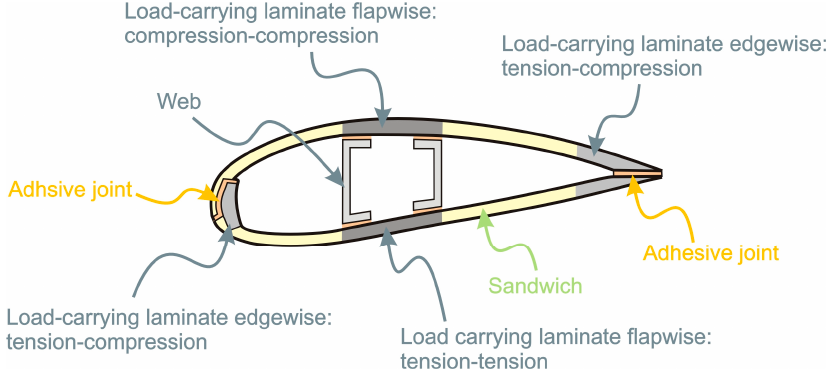
Figure 2. Schema of the section of the blade.